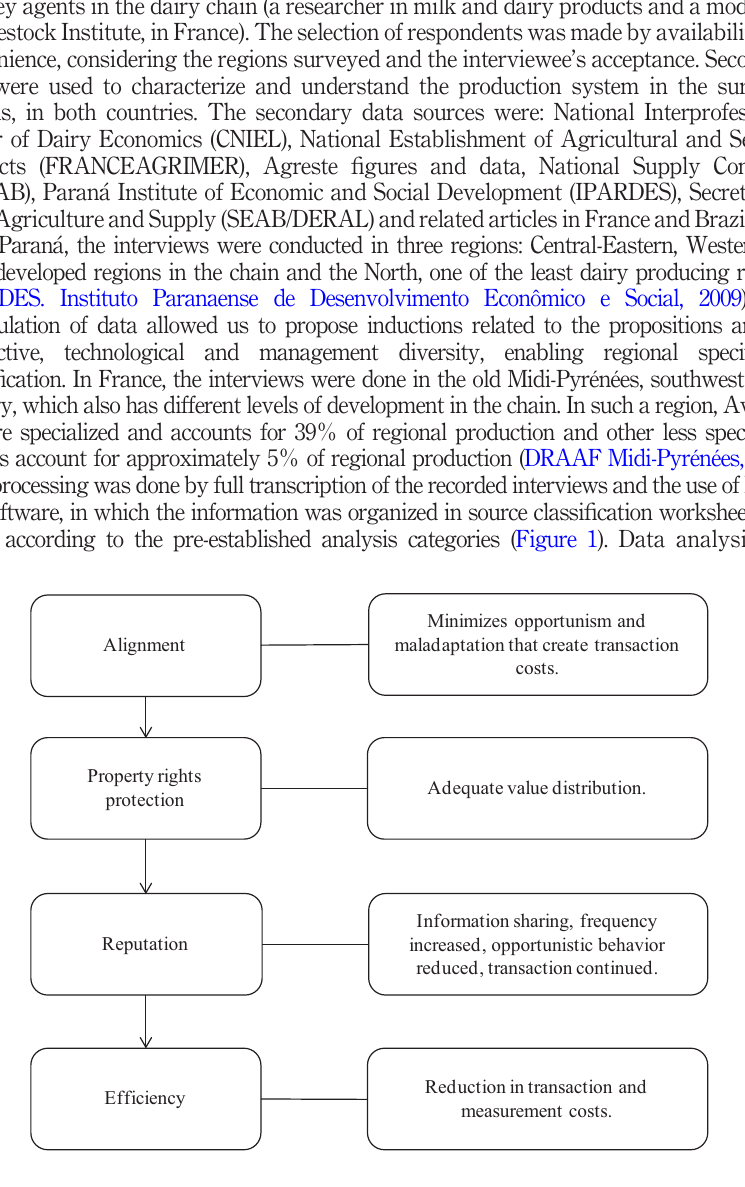
Figure 1. Analysis categories